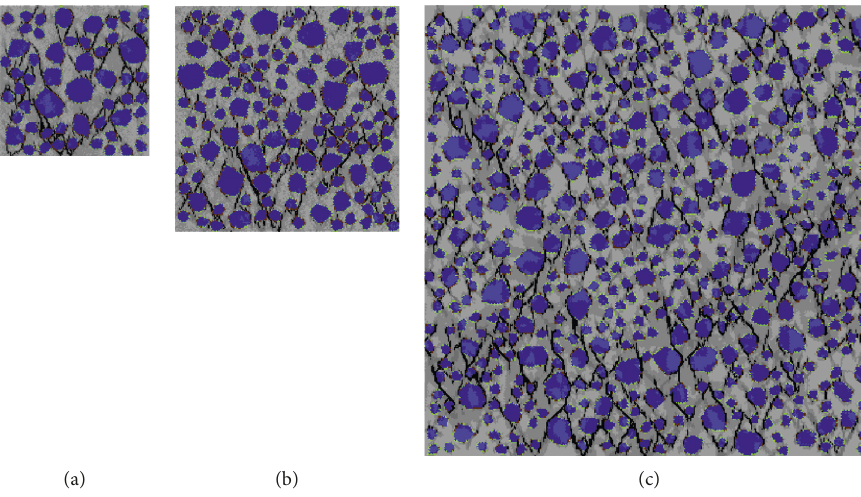
Figure 21: Failure patterns of concrete for different size models. (a) 100mm. (b) 150mm. (c)